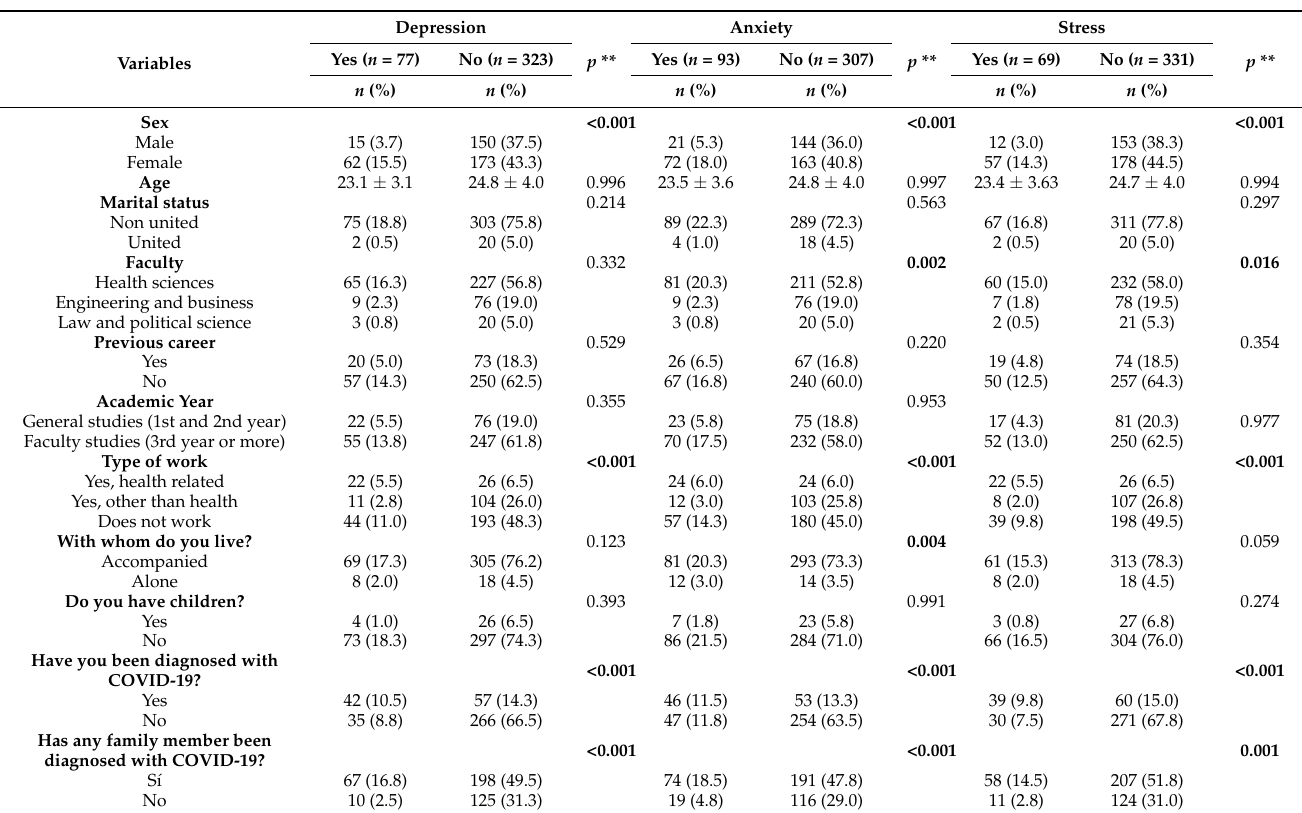
Table 2. Factors associated with presenting depression, anxiety, and stress in students of the Univer- sidad Norbert Wiener. Bivariate